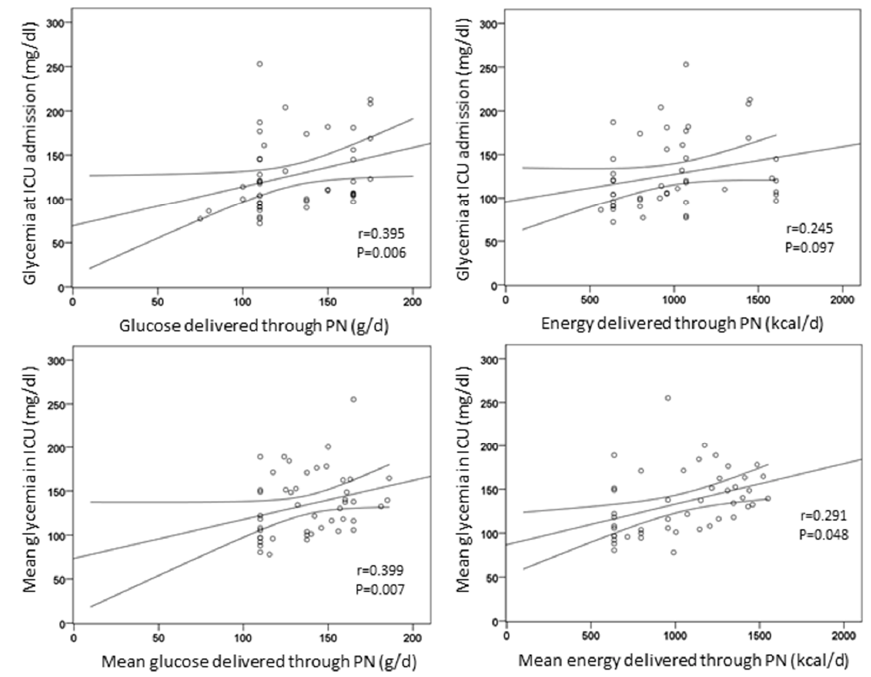
Figure 2. Correlations of energy and glucose delivered through artificial nutrition with glycemia.